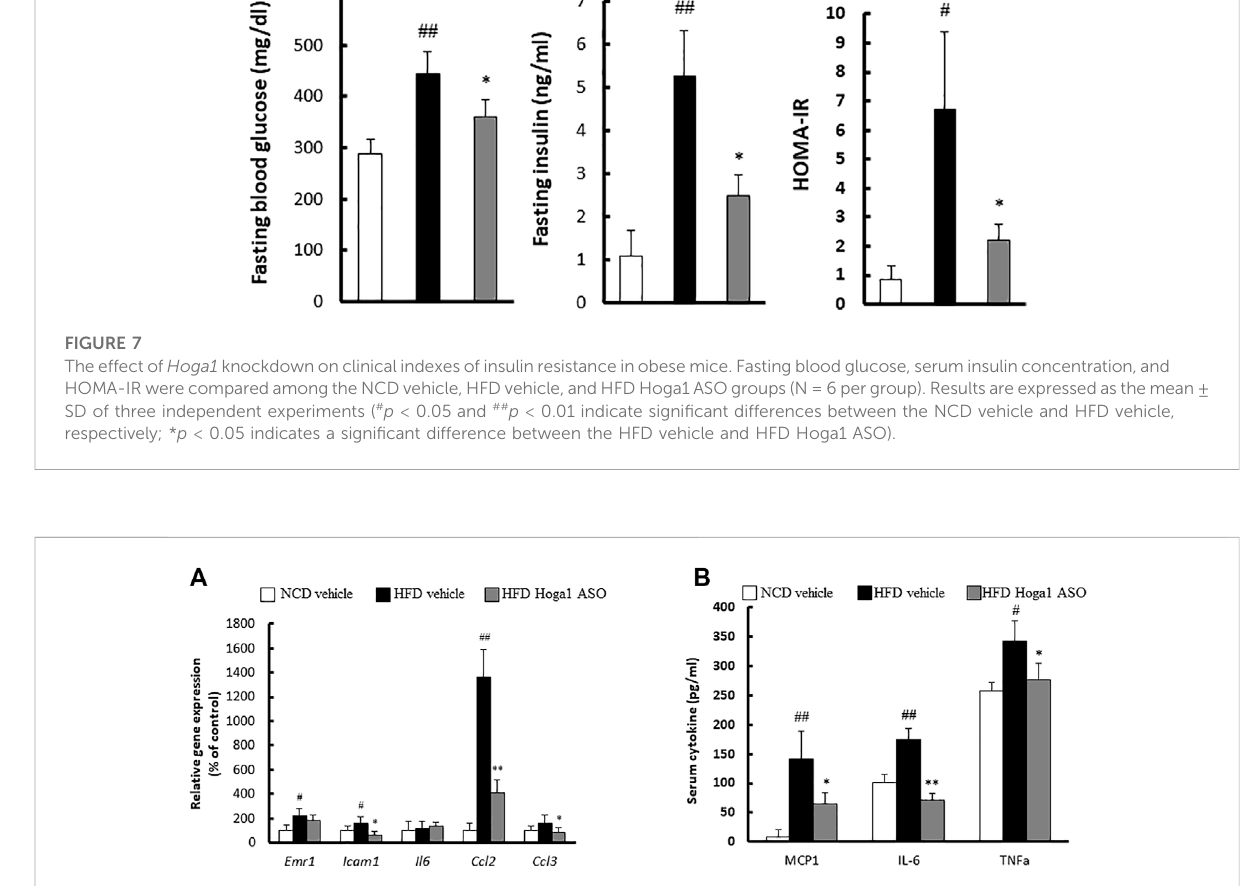
FIGURE 8 The effect of Hoga1 knockdown on adipose tissue in fl ammation in obese mice. (A) mRNA expression of in fl ammatory genes in eWAT was measured from NCD and HFD mice treated with scrambled control ASO or Hoga1 ASO (N = 5 per group). (B) Serum in fl ammatory cytokine concentrationscomparedamongtheNCDvehicle,HFDvehicle,andHFDHoga1ASOgroups(N=5pergroup).Resultsareexpressedasthemean± SD of three independent experiments ( # p < 0.05 and ## p < 0.01 indicate signi fi cant differences between the NCD vehicle and HFD vehicle; * p < 0.05 and ** p < 0.01 indicate signi fi cant differences between the HFD vehicle and HFD Hoga1